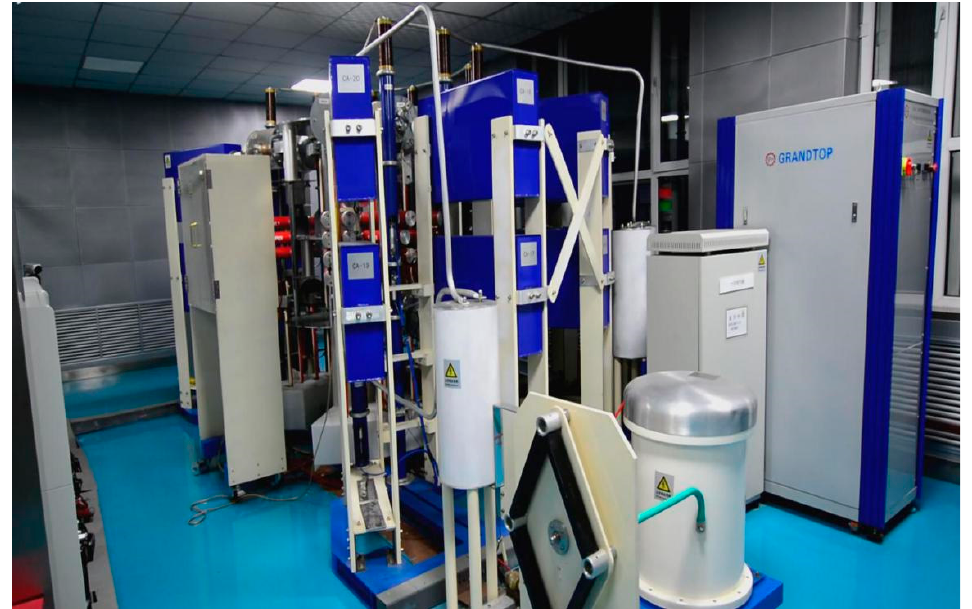
Figure 1. A 20-pulse lightning impulse current generator.